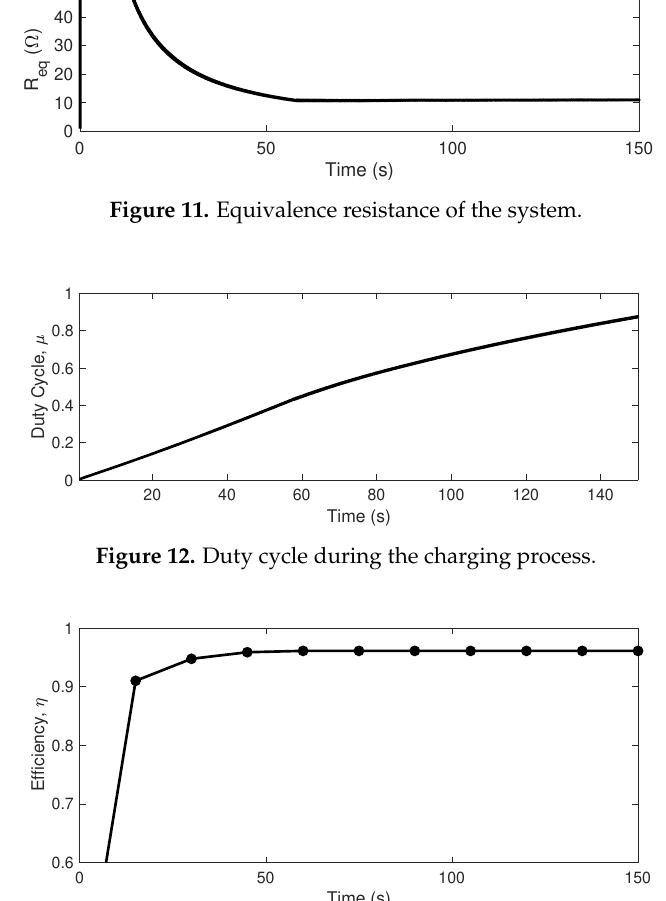
Figure 13. WPT system efficiency during charging process.